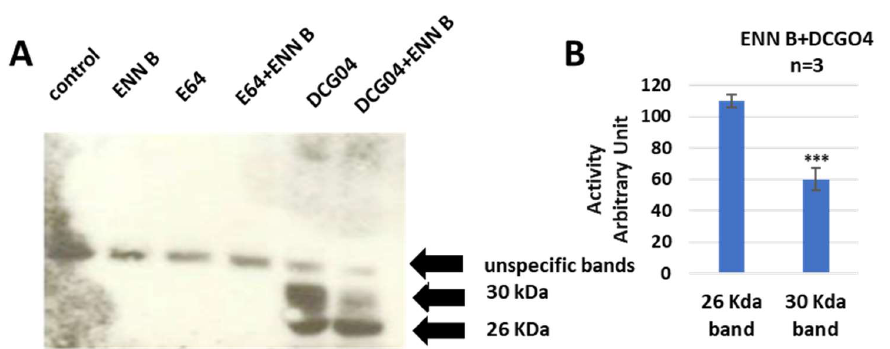
Figure 2. Impact of ENN B on the active site labelling of cysteine cathepsins by DCG04. ( A ) Active-site labelling with DCG04 was performed as described in materials and methods. Cells were harvested, and proteins were then subjected to protein electrophoresis and Western blotting with streptavidin–horseradish peroxidase. ( B ) Cellular content of 26 KDa and 30 KDa bands in cells treated with ENN B and DCG04 were compared to cells treated with only DCG04. The data were analyzed by t -test and statistics using GraphPad Prism. *** p < 0.001. Graphs are shown as mean ± SE, N = 7) .